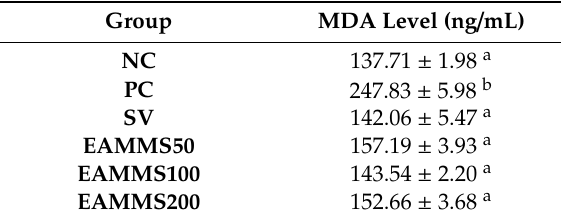
Table 4. E ff ect of ethyl acetate extract of Mikania micrantha stems (EAMMS) on lipid peroxidation using TBARS assay in hypercholesterolemia rats at week 8.